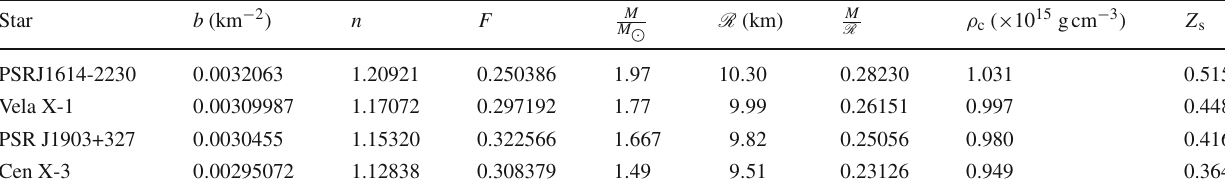
Table 1 Variation of mass, radius and central density in terms of b and n . The parameters b and n are variable